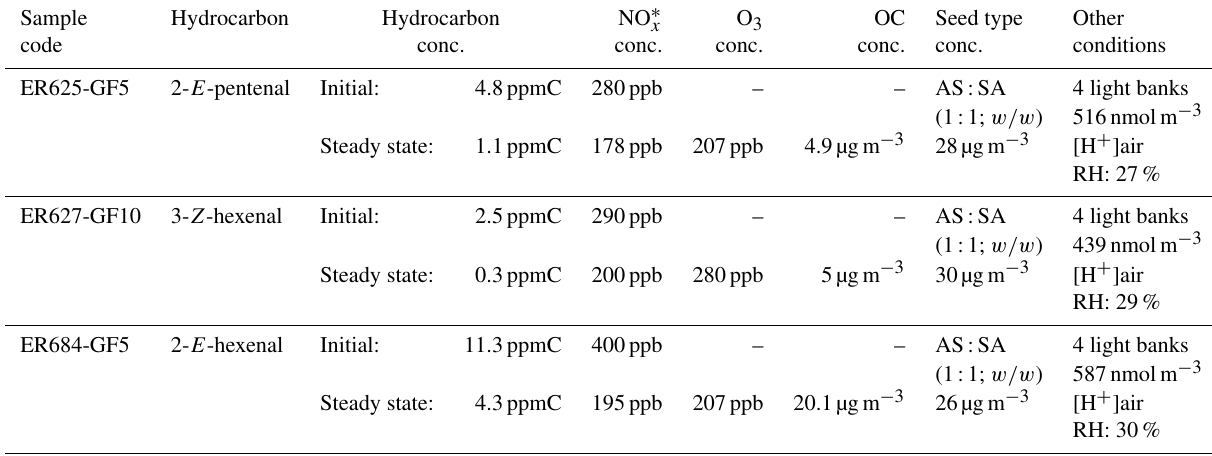
Table 1. Chamber conditions for experiments used for the structural characterization of unknown organosulfates related to 2- E -pentenal, 2- E -hexenal, and 3- E -hexenal SOA. Abbreviations: AS, ammonium sulfate; SA, sulfuric acid; RH, relative humidity.